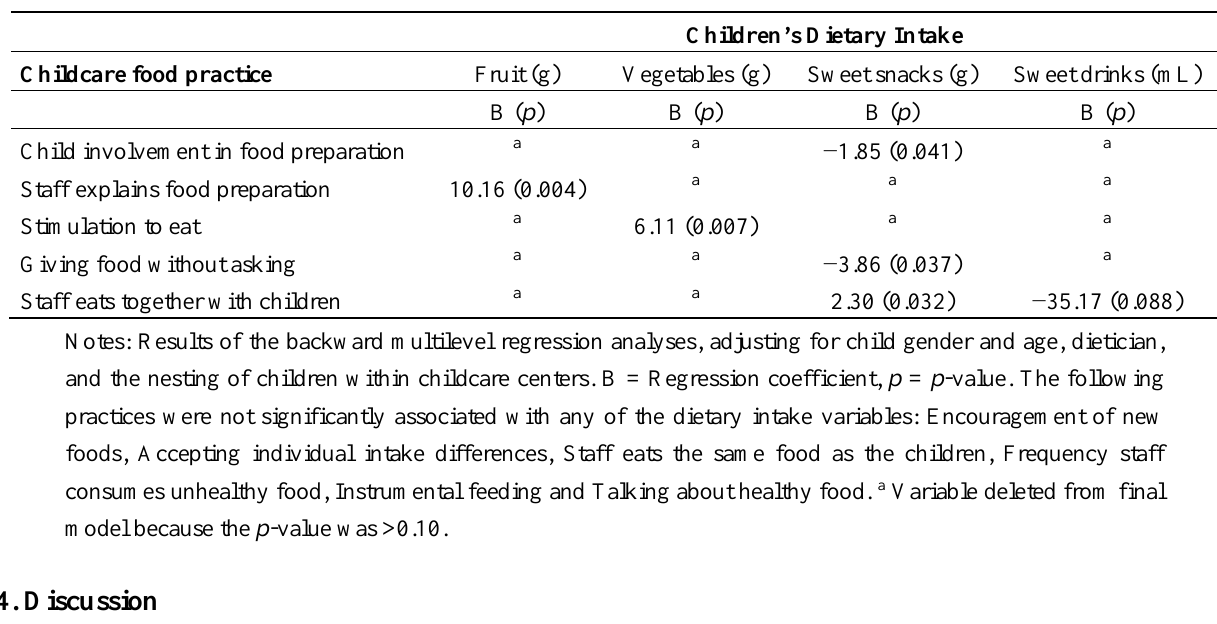
Table 4. Association between childcare food practices and children’s dietary intake ( N = 398). Childcare food